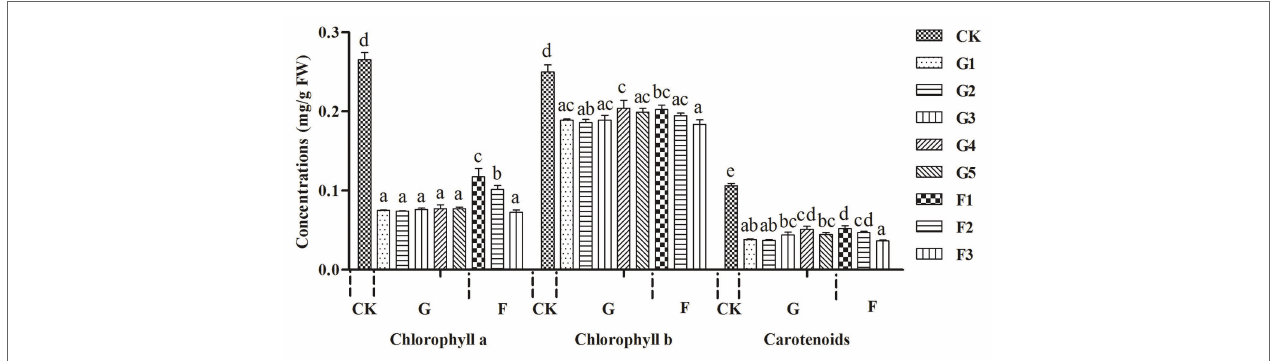
FIGURE 2 | Variations in concentration of photosynthetic pigments in galls tissues and the cones of Picea koraiensis . CK = normal branches. Data are presented in milligrams per gram of fresh weight (mg/g FW). G1–G5 represent the different developmental stages of gall tissues and F1–F3 represent different developmental stages of cones. G: gall tissues; F: cones. Mean differences were compared using one-way ANOVA with Tukey’s test. The different small letters (a, b, c, and d) represent significant difference at 0.05 level. These results shown represent the average ± SD.